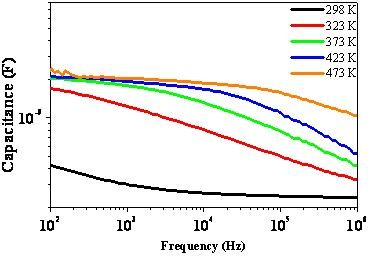
C-f curves at different temperatures on the as-fabricated Pt/CCTO/IrO2 capacitors.